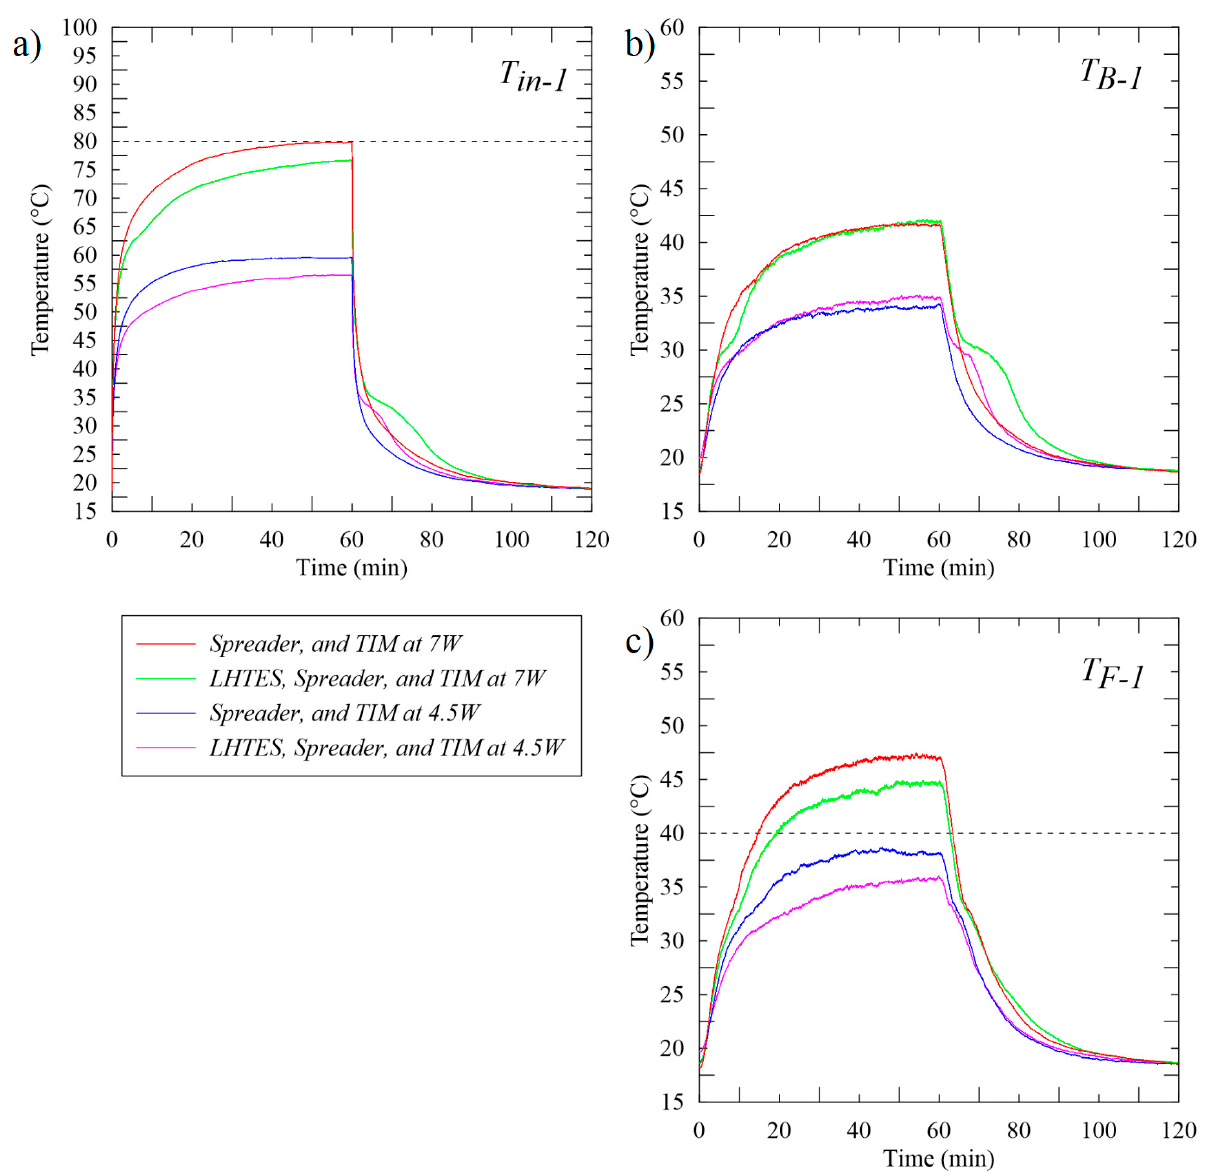
Figure 13. Maximum temperatures measured for the best two temperature control solutions at 4.5 and 7 W: ( a ) inside the mock tablet T in-1 , ( b ) on the back surface of the mock tablet T B-1 , and ( c ) on the front surface of the mock tablet T F-1 (the dashed line represents the relevant temperature limit).